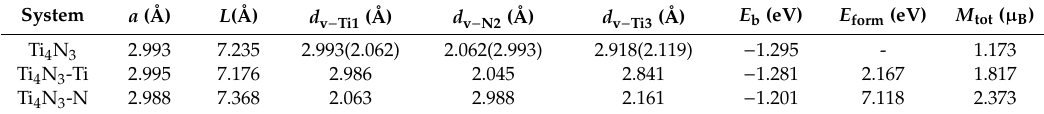
Table 2. Calculated lattice constants a , atomic layer thickness L , binding energy E b and formation energy E form and total magnetic moment M tot , where bond lengths between the vacancy atom at surface (or subsurface) and its neighbor Ti1, N2 or Ti3 atom at surface, subsurface or next subsurface, respectively.